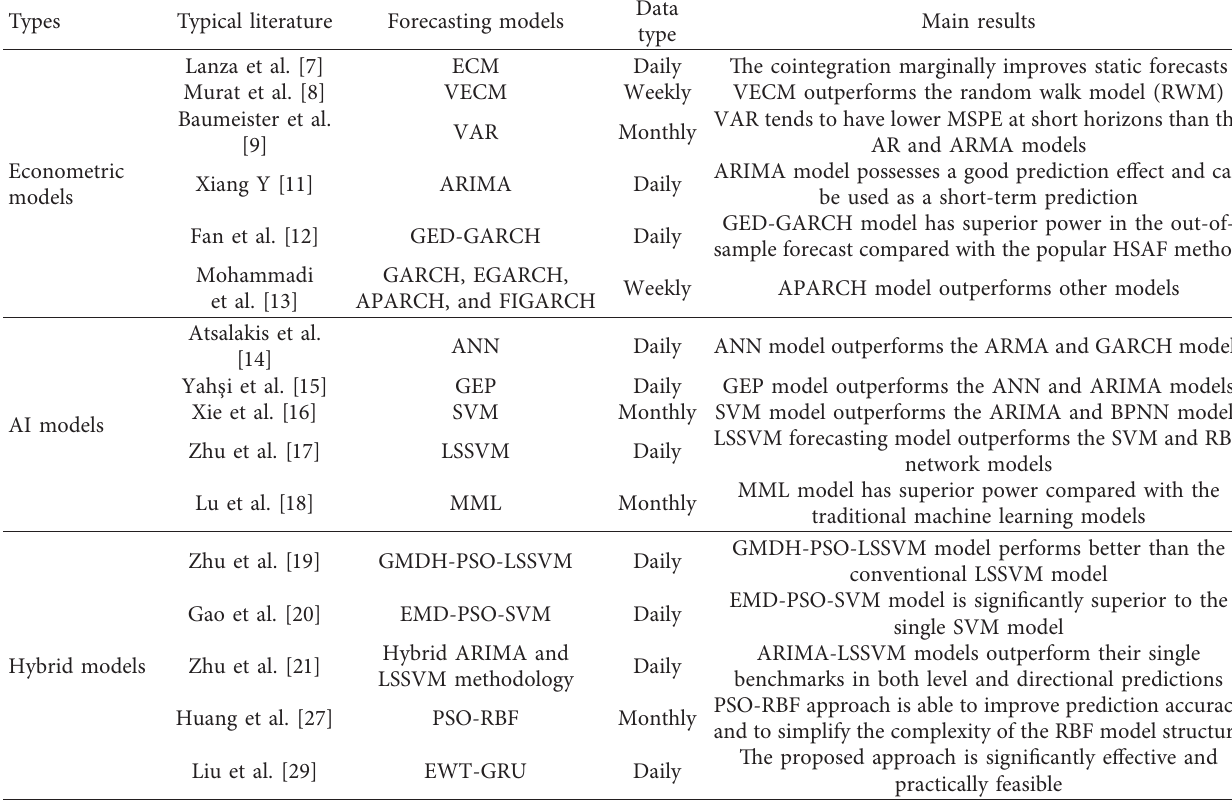
Table 1: Summary of studies on price forecasting via various